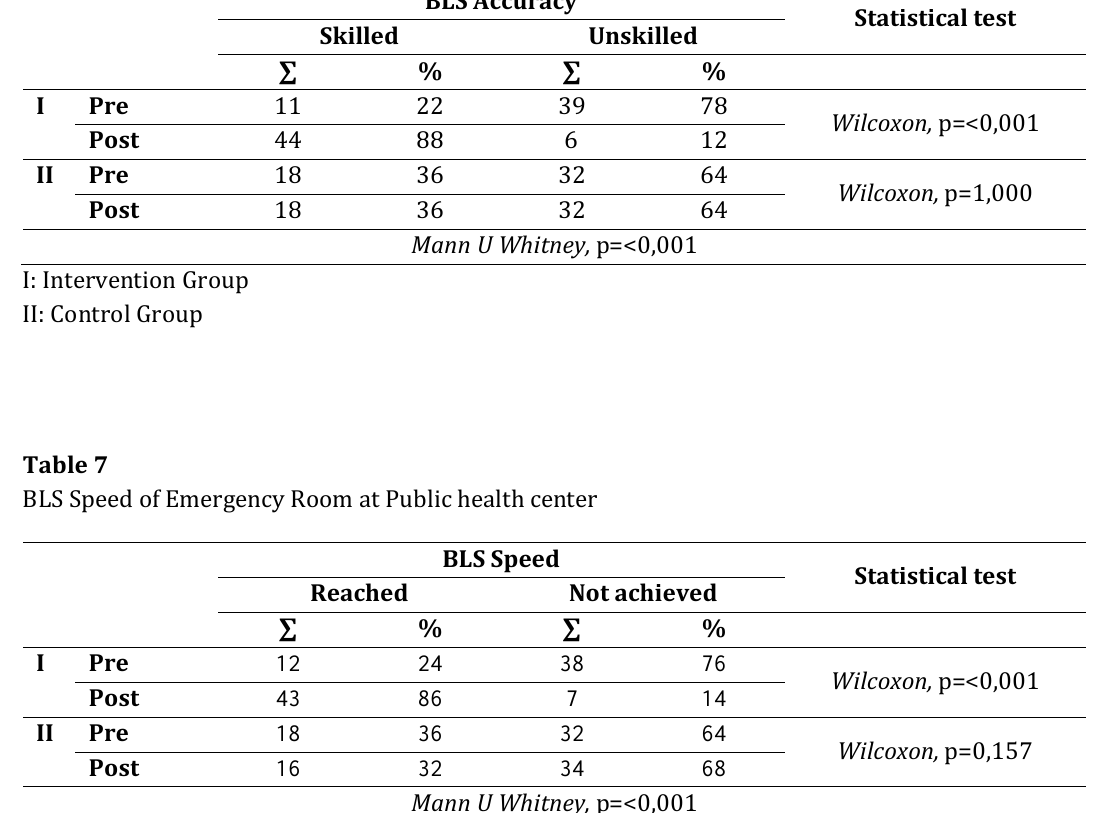
Statistical test